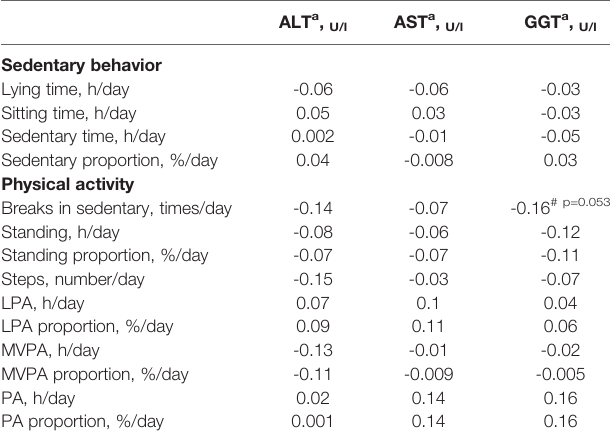
TABLE 2 | Age and sex-adjusted Pearson partial correlation coef fi cients between circulating liver enzymes (ALT, AST, GGT), anthropometrics and health measurements.